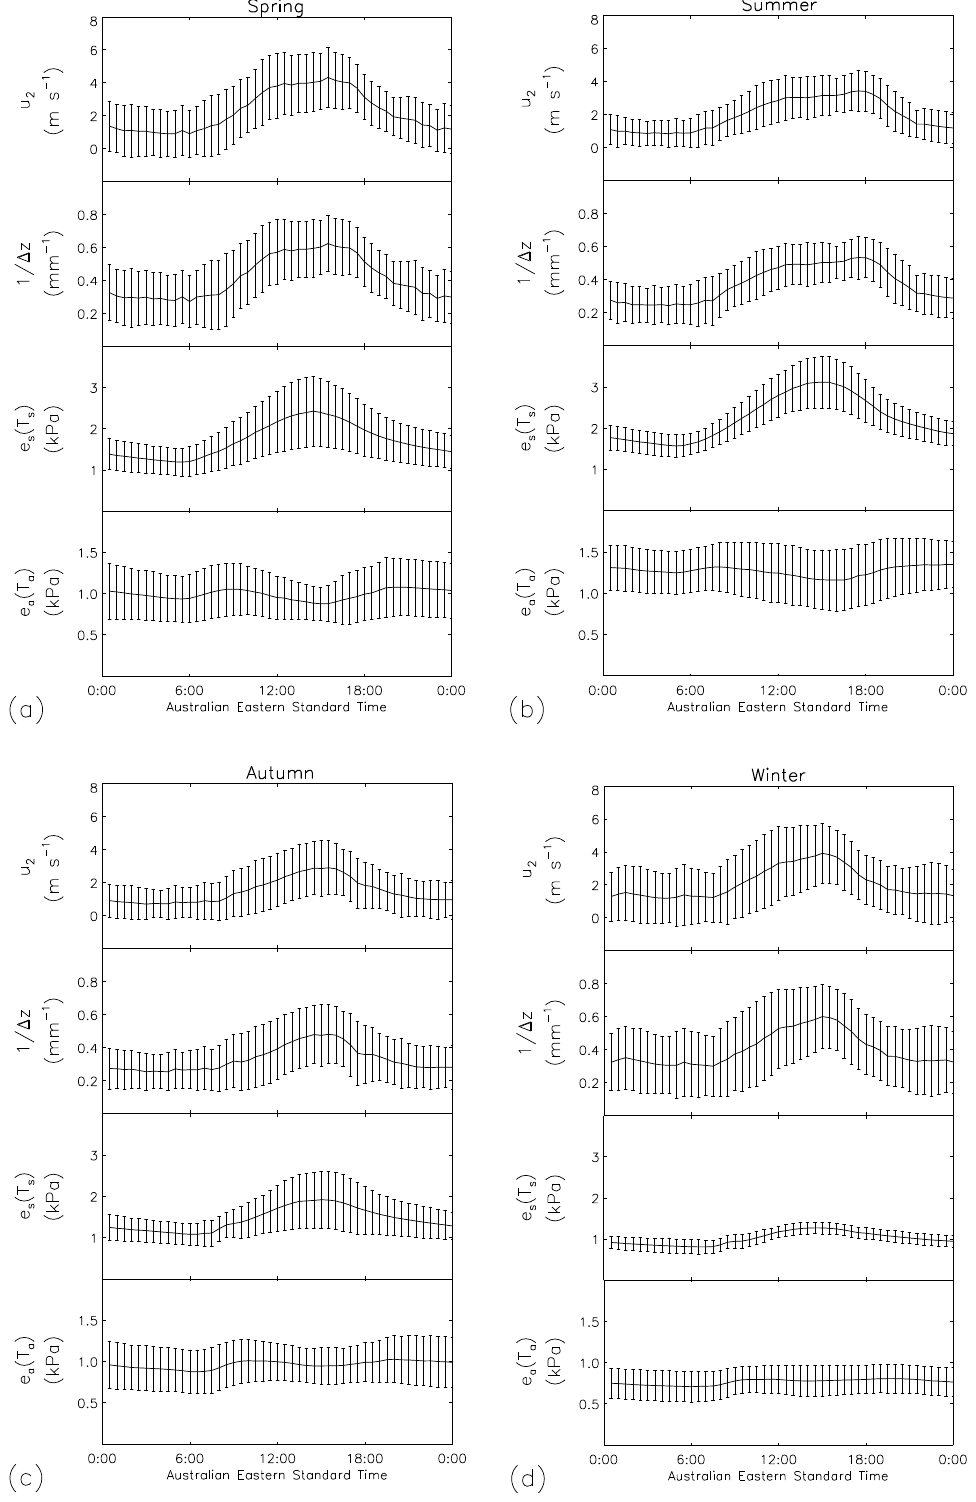
Fig. 8. Mean diurnal cycle (based on half-hourly time intervals) during (a) spring (36 days), (b) summer (64 days), (c) autumn (68 days) and (d) winter (69 days). Plots show wind speed at 2m a.g.l. ( u 2 ), inverse of boundary layer thickness ( 1 surface ( e s (T s ) ) and air vapour pressure ( e a (T a ) ). Error bars denote ± 1 population standard deviation.